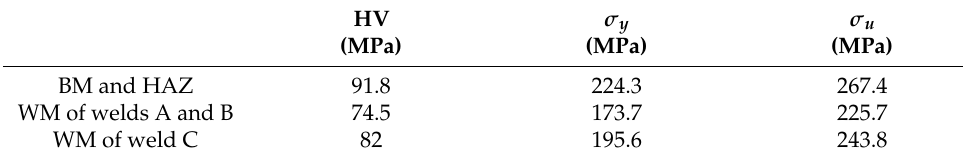
Table 2. Static properties from hardness measurements.